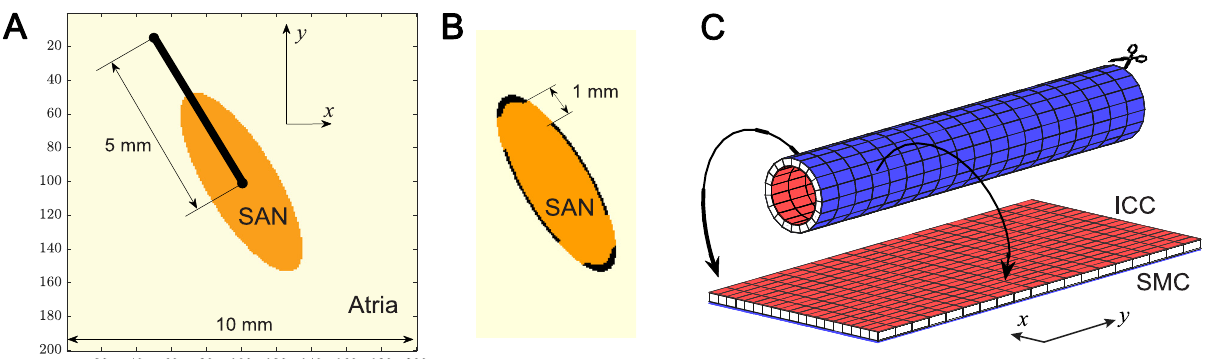
Fig 3. Schematics of the simulation examples. A. 2D SAN model with the pAP-AP cells. B. SAN structure with a border of passive tissue and exit pathways. C. 3D intestine model with the pCN-CN cells.